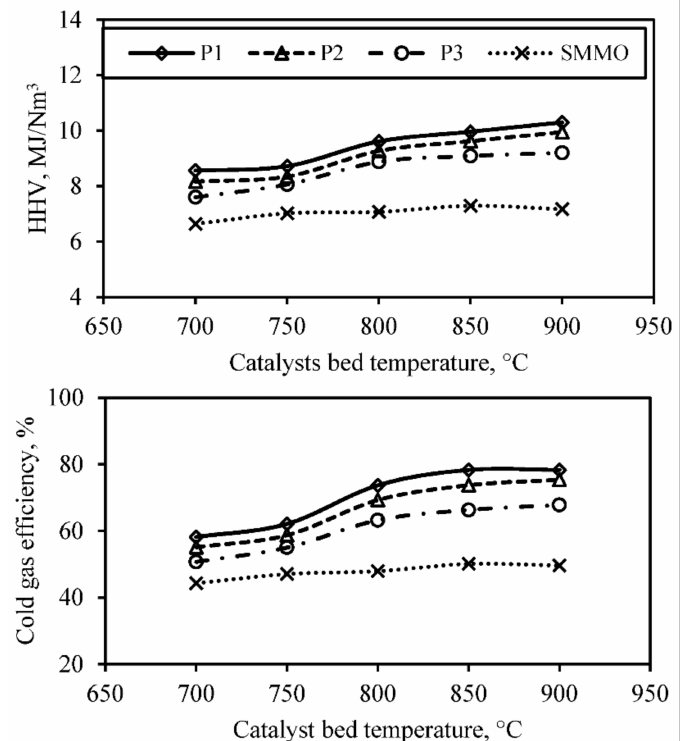
Figure 5. Effect of different catalyst to biomass (C/B) ratio on gasification performance.